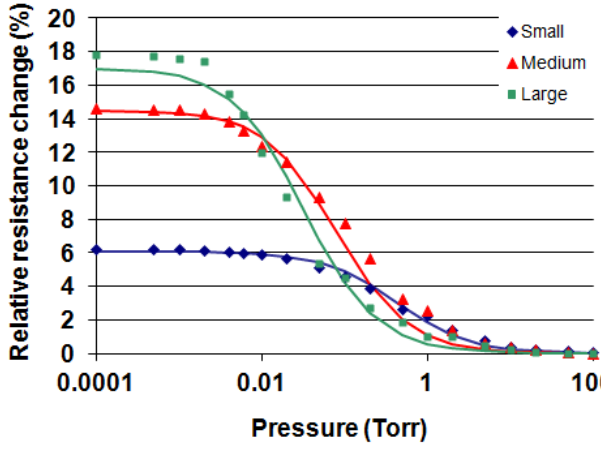
Figure 6. Relative resistance change (%) of a small (470 µm), medium (1,040 µm) and large (2,740 µm) membrane Pirani gauge as a function of pressure. The power applied to the heating elements at 760 Torr was 2 mW. The devices were measured in constant voltage mode. The solid curves are calculated values.